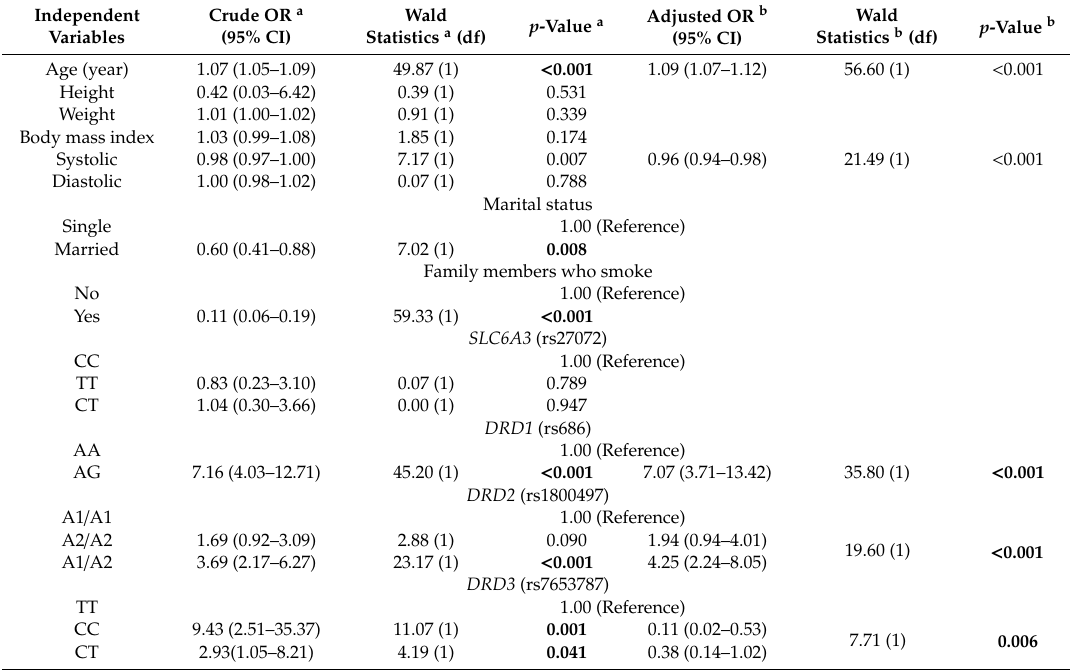
Table 2. Factors associated with smoking